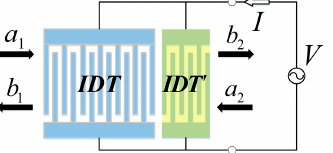
Figure 12. The schematic of P -matrix in IDT section.